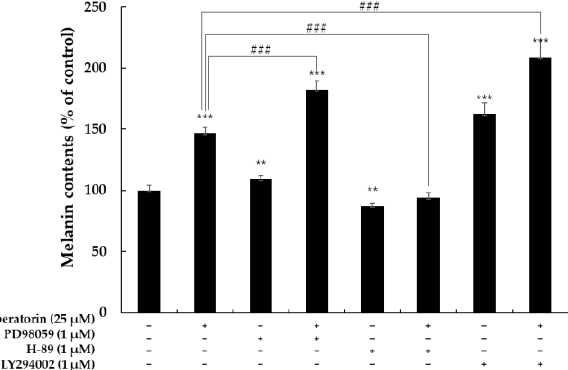
Figure 9. Effect of inhibitor on imperatorin-indued melanin contents in B16F10 cells. To determine the involvement of ERK, AKT, PKA enzyme in melanogenesis, melanin content was conducted using the PD98095, H-89, and LY294002. The results are presented as the mean ± SD from three independent measurements using the Image J. ** p < 0.01 and *** p < 0.001 vs untreated group. ### p < 0.001 vs imperatorin treated group.